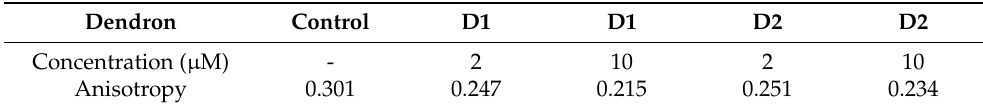
Table 1. Fluorescence anisotropy of liposomes (control) and after adding 2 µ M and 10 µ M of D1 and D2 dendrons.